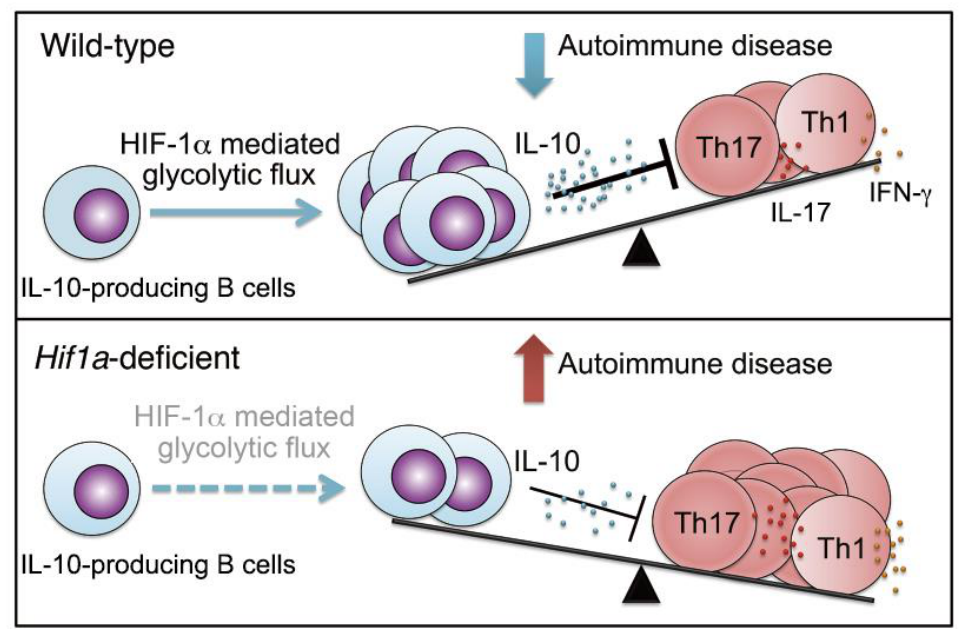
FIGURE 1: Role of HIF- 1α-mediated glycolysis in expansion and func- tion of IL-10-producing B